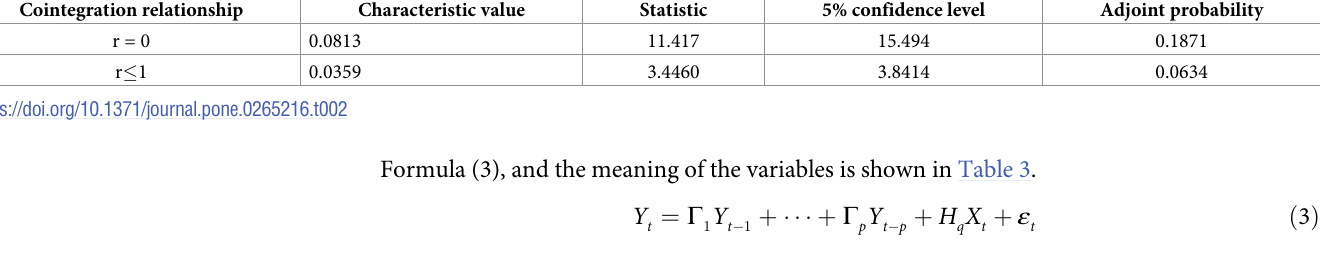
4.2.2 Model lag order selection. The optimal lag order of the model is selected according